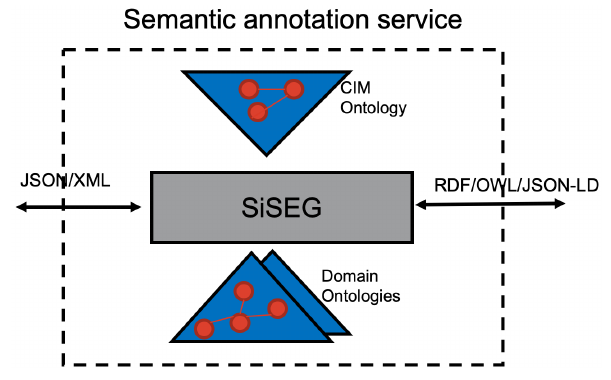
Figure 3. Semantic annotation service